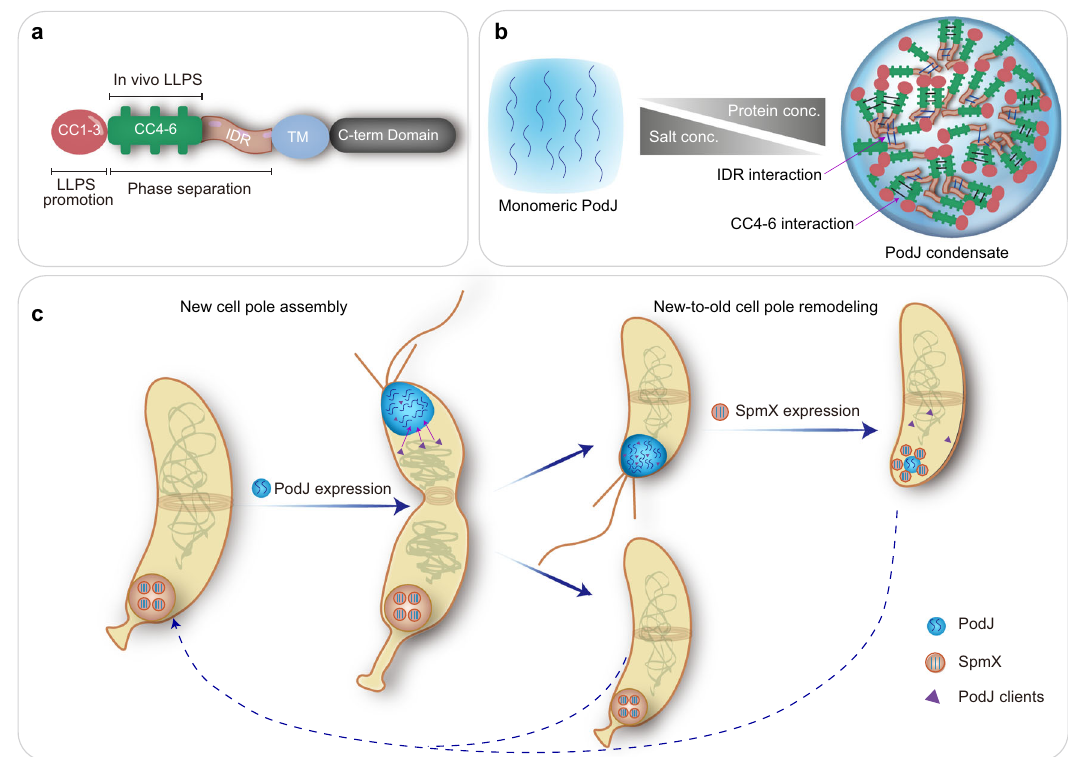
Fig. 6 | Schematic of PodJ phase separation and the proposed model for reg- ulating bacterial asymmetric cell division. a Functional domain architecture of PodJ.BothCC4 – 6andIDRareresponsibleforPodJphaseseparationinvitro.CC4 – 6 is the sole domain suf fi cient to drive PodJ LLPS in vivo and CC1 – 3 is the domain functioning in LLPS promotion. b The monomeric PodJ_N undergoes phase separation into biomolecular condensates, which are regulated by